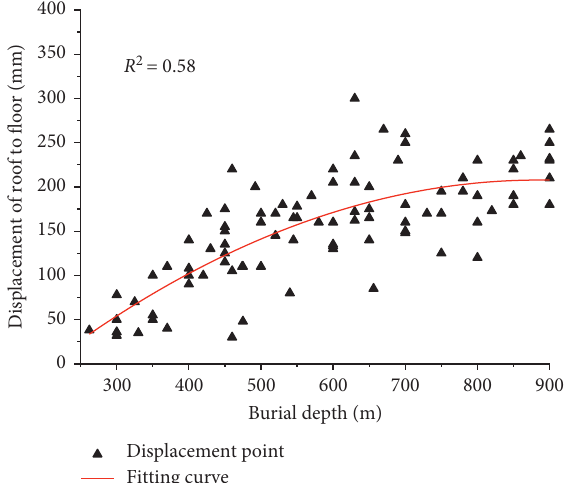
Figure 1: Displacement of roof to floor (5 th day).